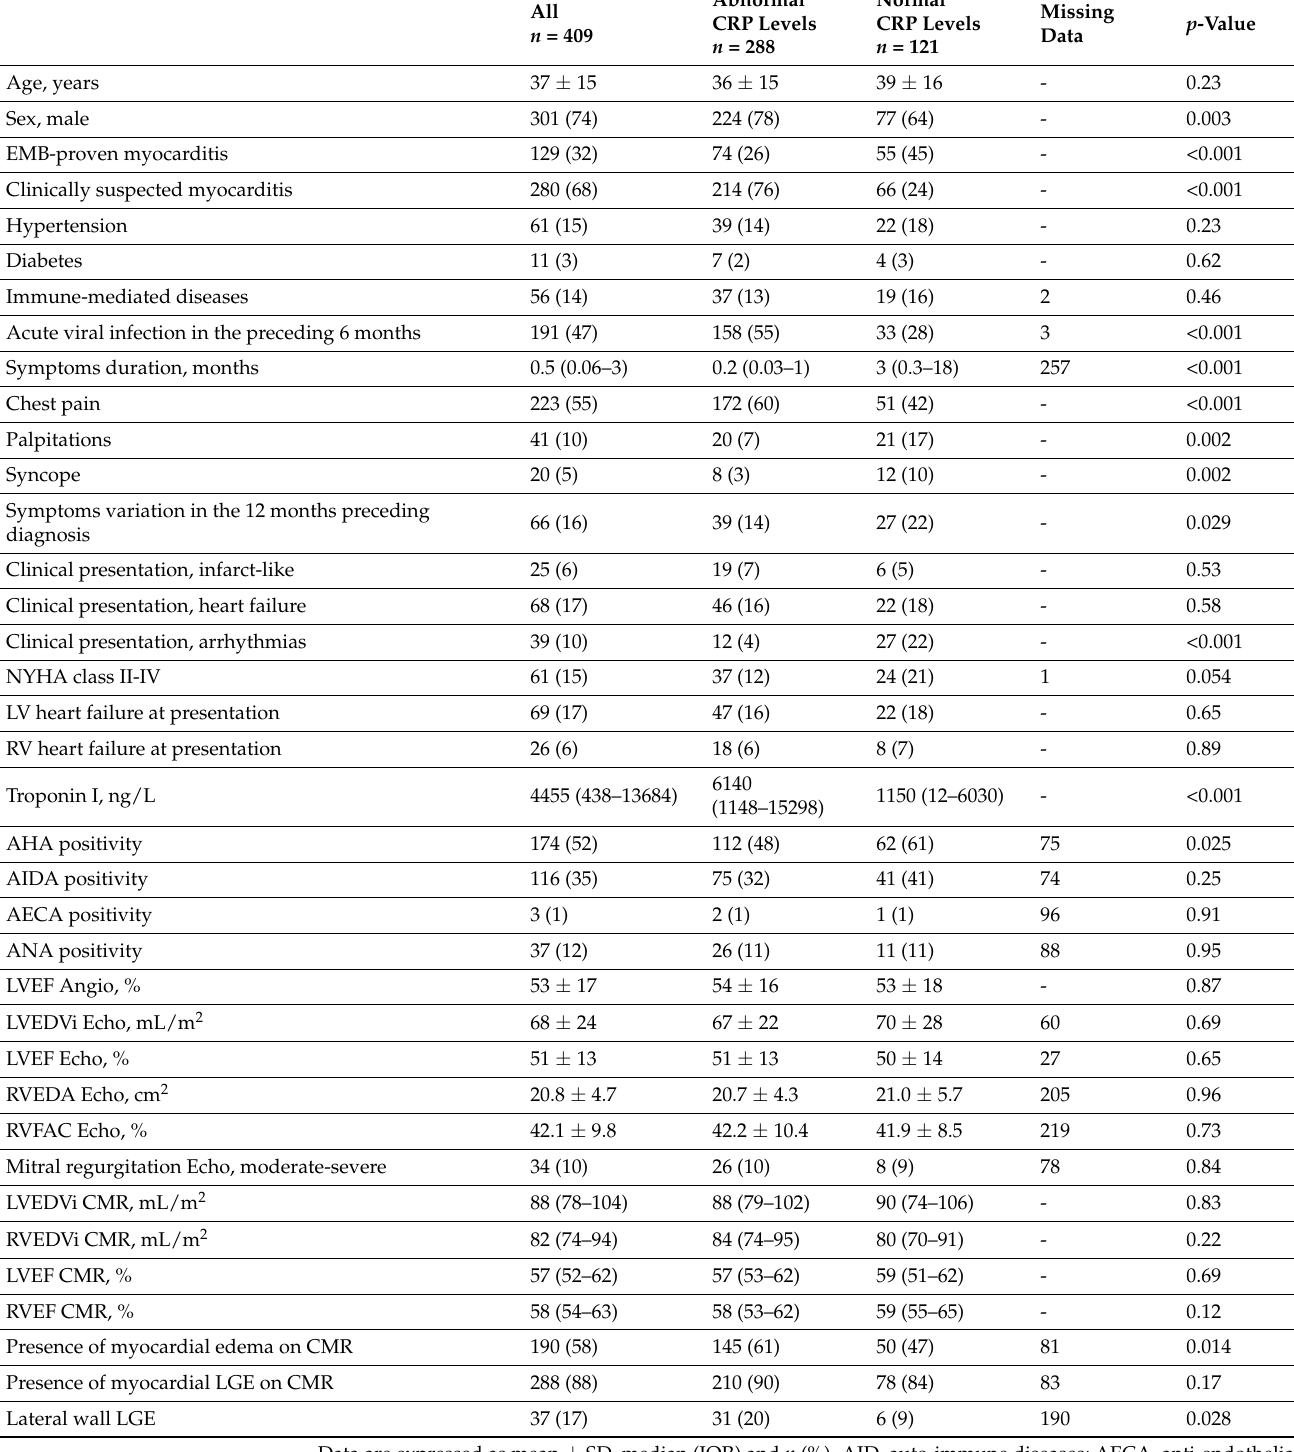
Table 1. Patients’